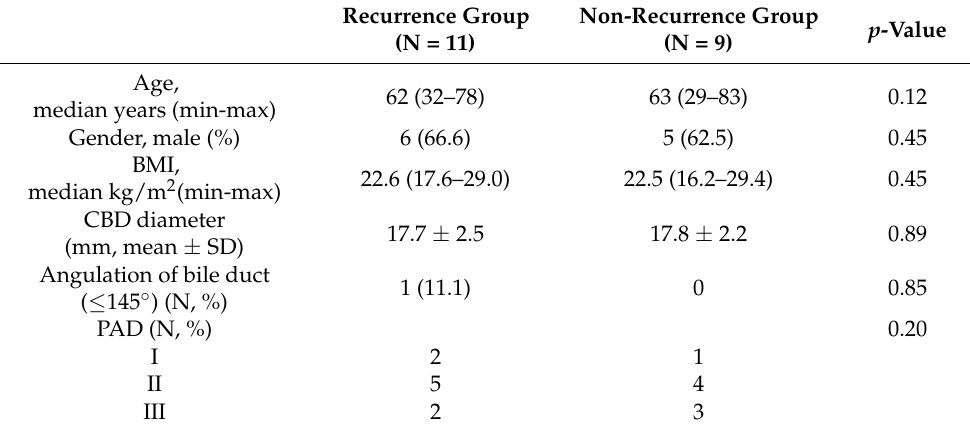
Table 1. Baseline